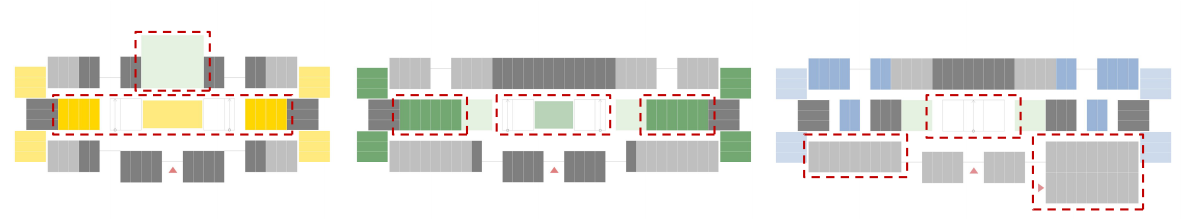
Figure 5. WOODUL – the module that can do everything [12].